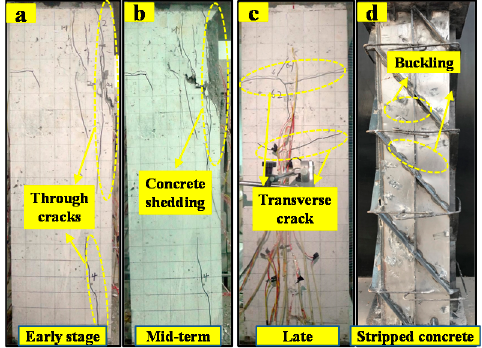
Figure 8. Z4 destruction phenomenon. ( a ) Early stage ( b ) medium stage ( c ) Late stage (d) Stripped concrete.